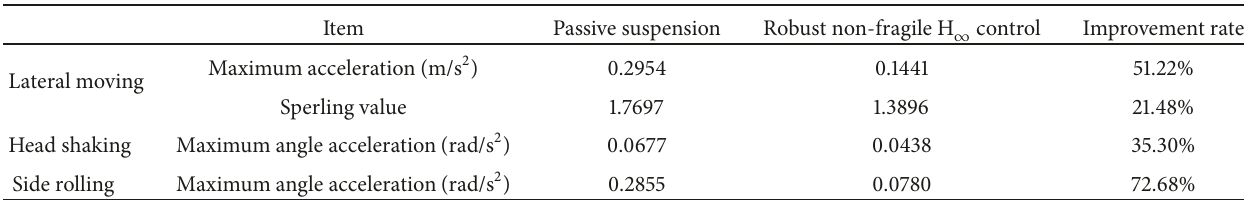
Table 1: Time domain analysis of the vehicle body lateral acceleration amplitude and Sperling value